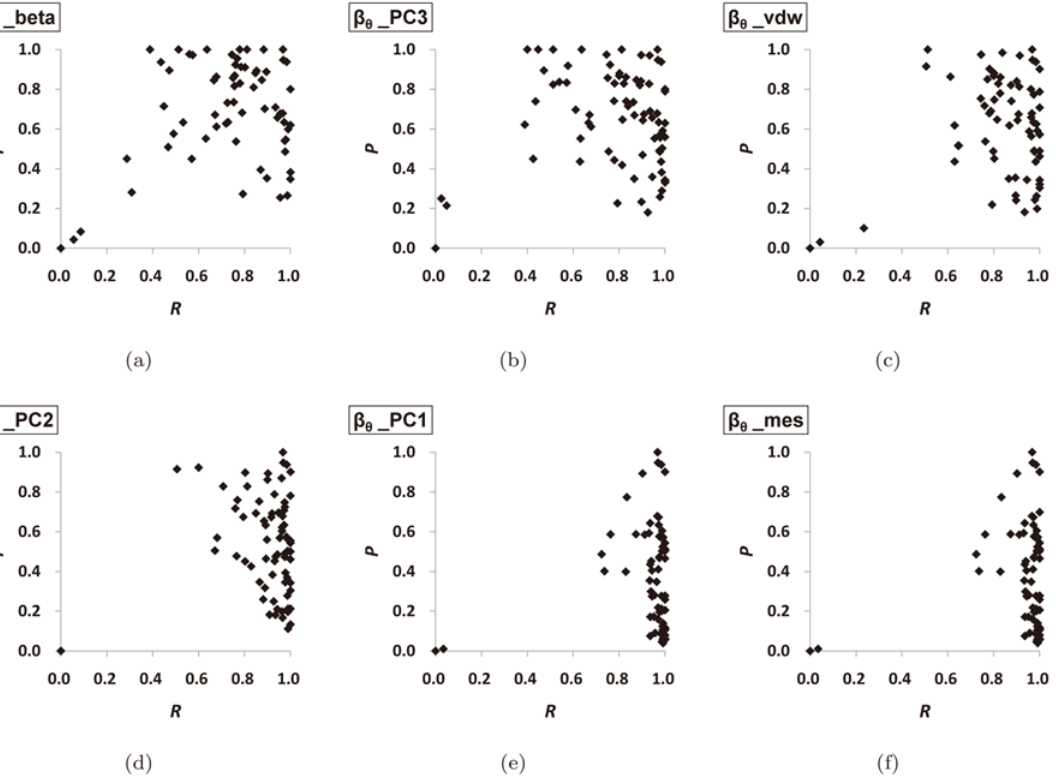
Fig 12. The PR-graph of the L-descriptors. (a) the beta-shape volume, (b) the PC3, (c) the van der Waals volume, (d) the PC2, (e) the PC1, and (f) the minimum enclosing sphere.